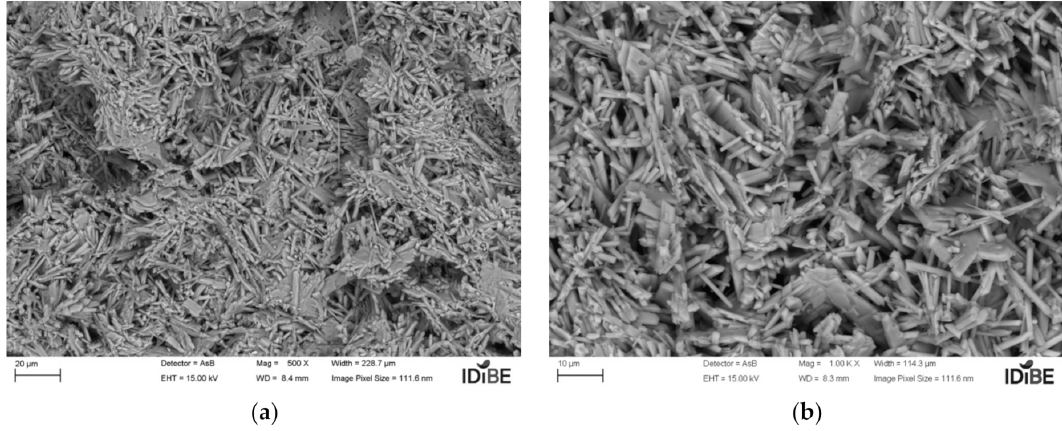
Figure 5. Micrograph of the 1.2% modified melamine compound (lot A3) ( a ) 20 µ m; ( b ) 10 µ m (source: the author).